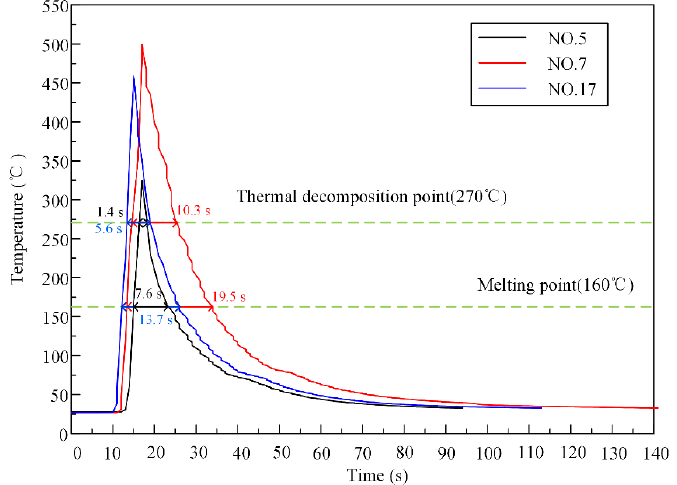
Figure 7. Relationship between the temperature and time of the typical specimens.